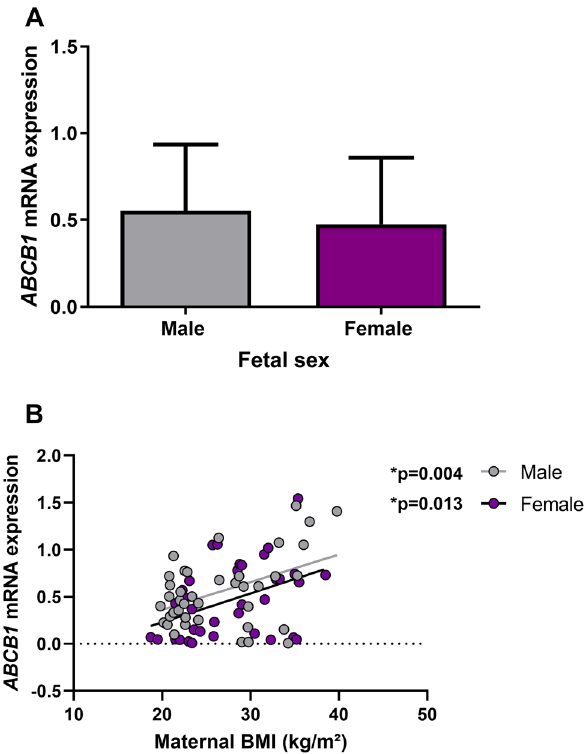
Figure 3. ABCB1 mRNA expression in placental tissue in relation to fetal sex. ( A ) Expression of ABCB1 in placental tissue between male (n = 40) and female (n = 35) fetuses. No significant difference between the two groups (Mann–Whitney test, Mann–Whitney U = 612, median = 0.503 (male) and median = 0.431 (female), p = 0.355). A p value < 0.05 was considered statistically significant. Each bar represents mean ± SD. ( B ) Expression of ABCB1 between male and female fetuses evaluated by linear regression, (male: Slope = 0.029, F(1,38) = 9.480 R 2 = 0.199, p = 0.004, female: Slope = 0.031, F(1,33) = 6.932 R 2 = 0.174, p = 0.013). Each dot represents one sample (n = 75), and line represents best fitted line. A p value < 0.05 was considered statistically